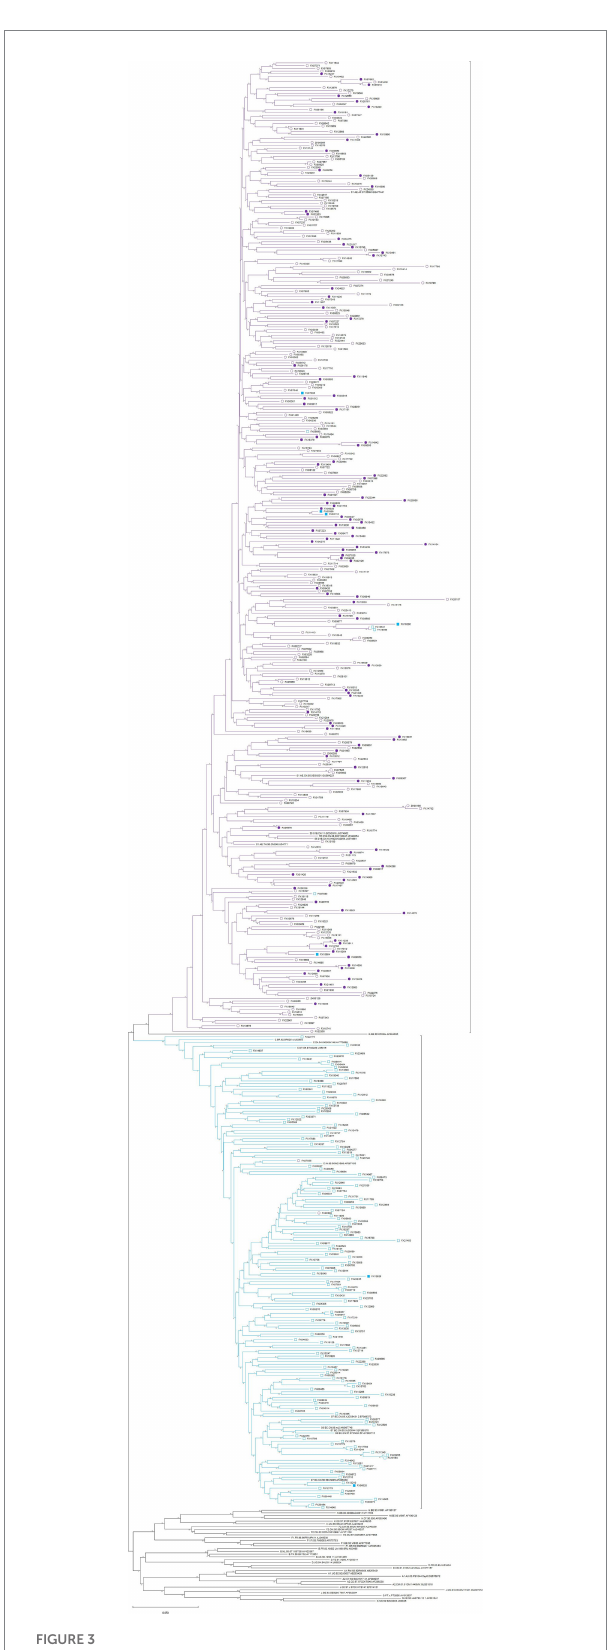
FIGURE 3 Phylogenetic tree (for HIV-1 env-c2v3 analysis) of the X4-tropic virus in CRF01_AE (the solid and hollow violet circles, respectively, represent X4-tropic and R5-tropic viruses) and CRF07_BC (the solid and hollow cyan squares, respectively, represent X4-tropic and R5-tropic viruses).